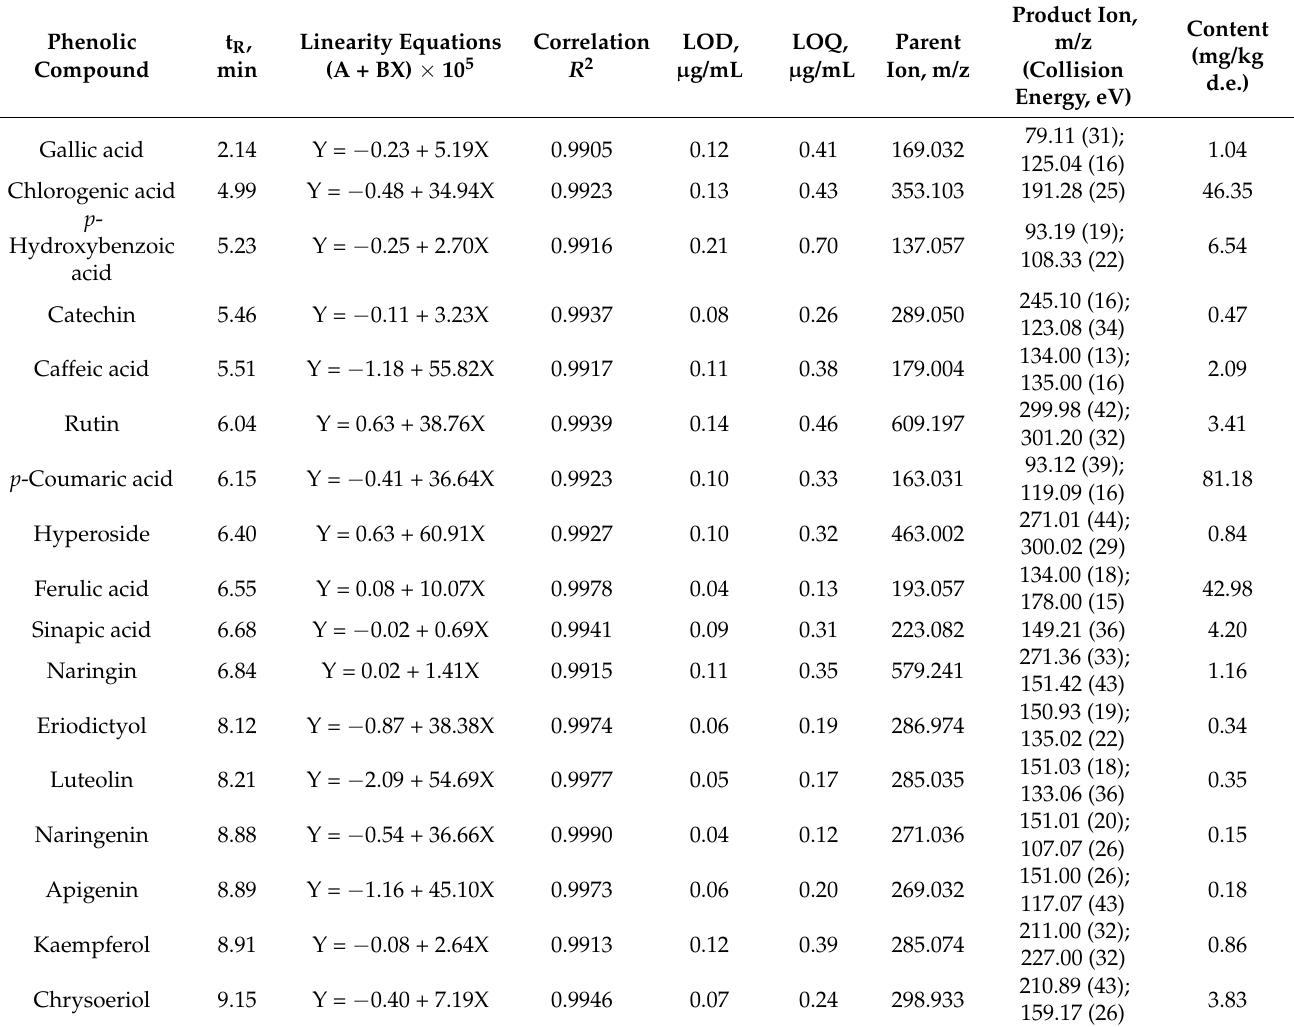
Table 2. UHPLC/( − )HESI–MS/MS quantitative method and data of targeted phenolic compounds in R. holostea extract. Concentration is presented as mg per kg of the dry extract [mg/kg d.e.]. Values are means of three replicates ±